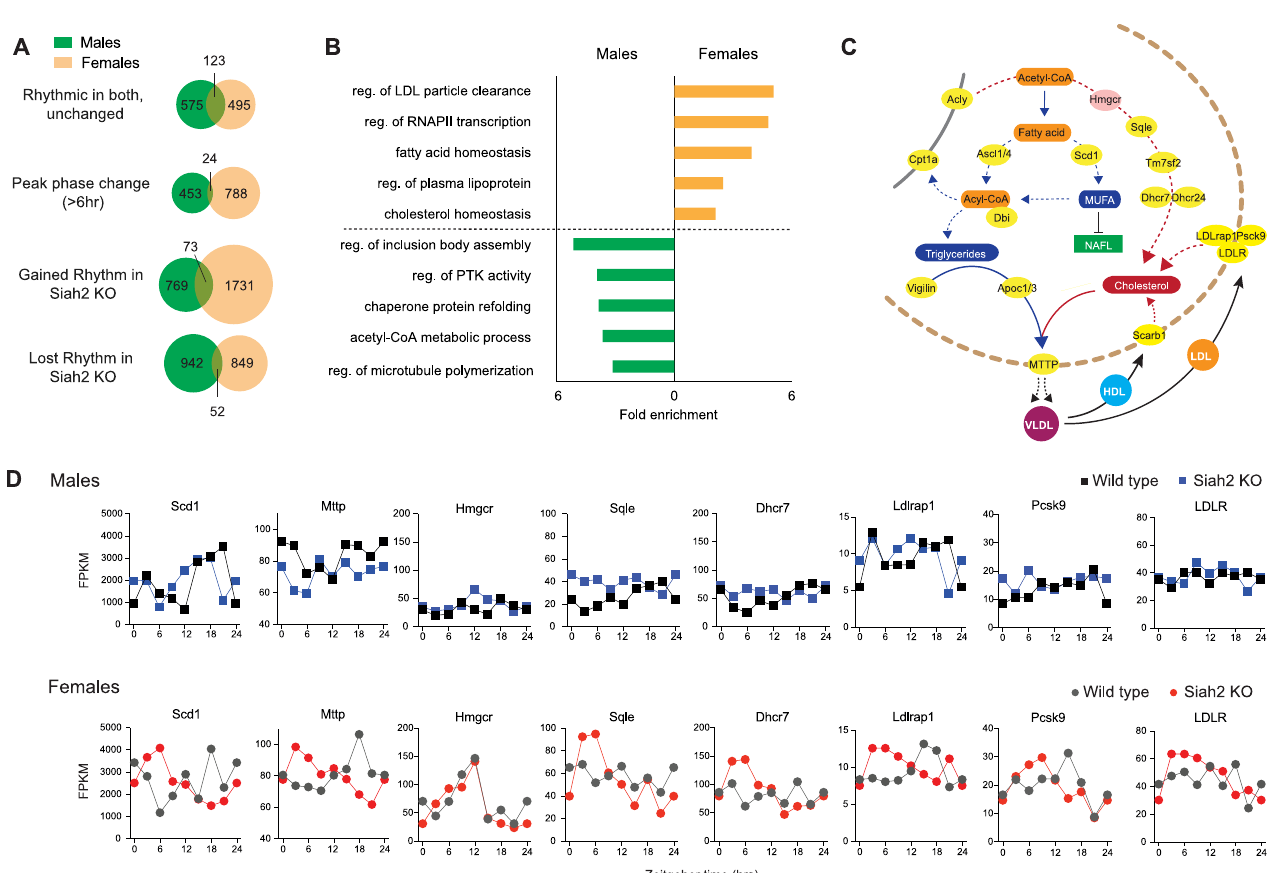
Fig 4. SIAH2 regulates rhythmic expression of lipid/lipoprotein metabolism genes in female livers. ( A ) Venn diagrams comparing the effects of SIAH2 loss between males and females on rhythmic gene expression. ( B ) Top gene ontogeny terms corresponding to the genes whose expression was affected by SIAH2 loss in both sexes. ( C ) Simplified lipid and cholesterol metabolic pathways in the liver, highlighting genes (yellow) uniquely affected by SIAH2 loss in females. ( D ) Examples of female-specific effects of SIAH2 loss on rhythmic gene expression. See also S2 and S3 Datasets .